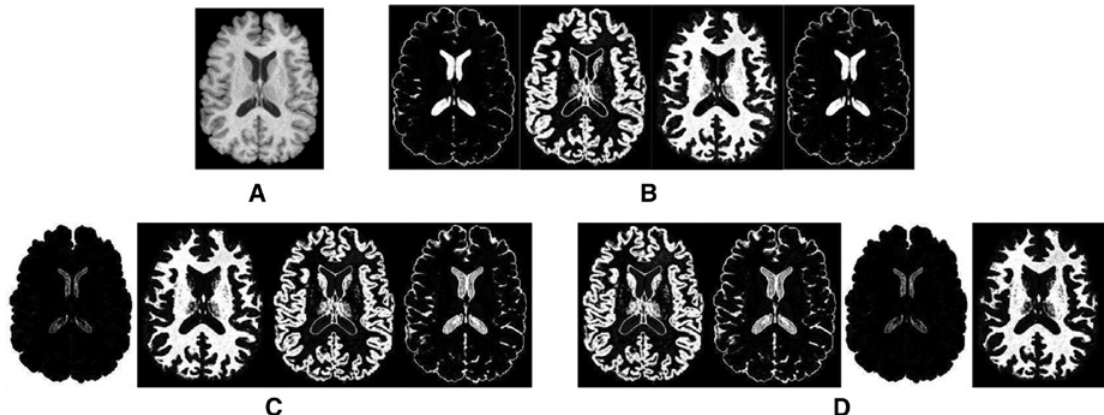
Figure 3: Segmentation Result of Alg6 With Different λ Values on Brain Image With Cluster Number = 4 (A) Input Image (B) λ = 0.5, (C) λ = 1, (D) λ = 5.